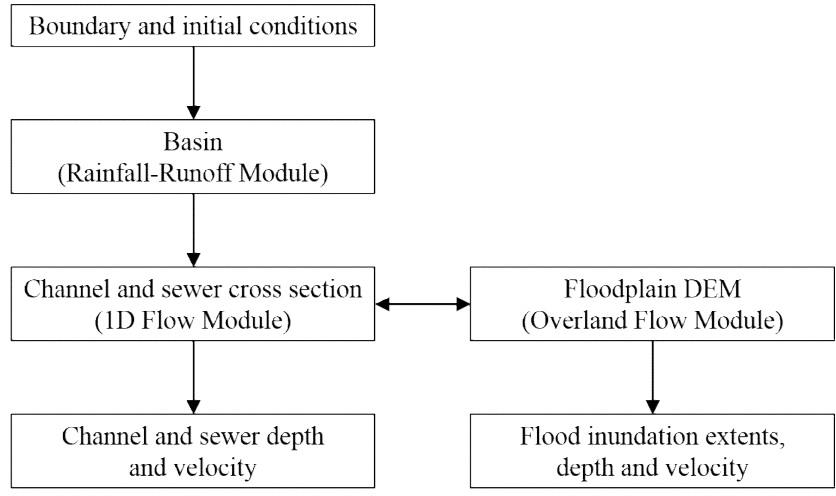
Figure 2. Flowchart of the SOBEK model.